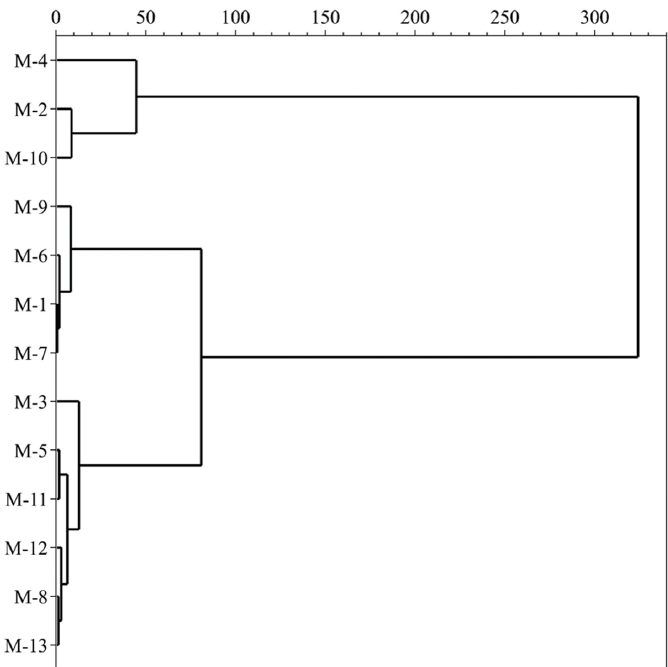
Figure 3. Hierarchical cluster analysis of the mulberry samples.